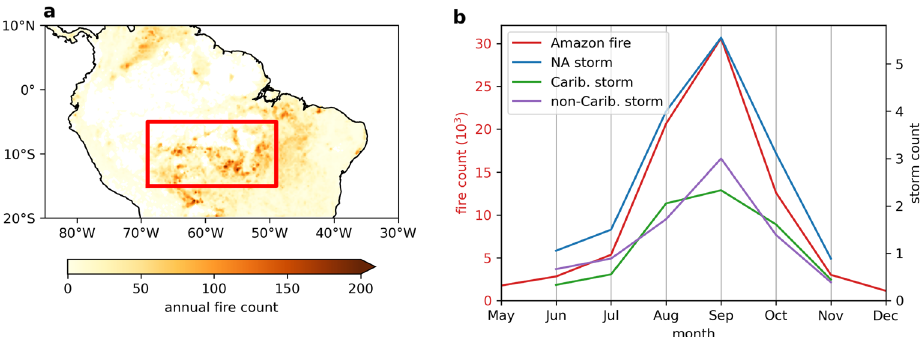
Figure 1. Climatology of Amazon fires and North Atlantic tropical storms. ( a ): Average annual fire count between 2001 and 2018. The red box is the most fire-active region. ( b ): Seasonal cycles of Amazon fire count and North Atlantic (NA), Caribbean (Carib.) and non-Caribbean (non-Carib.) tropical storm number computed from 2001 to 2018.